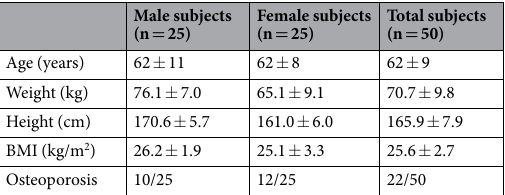
Male subjects (n = 25)